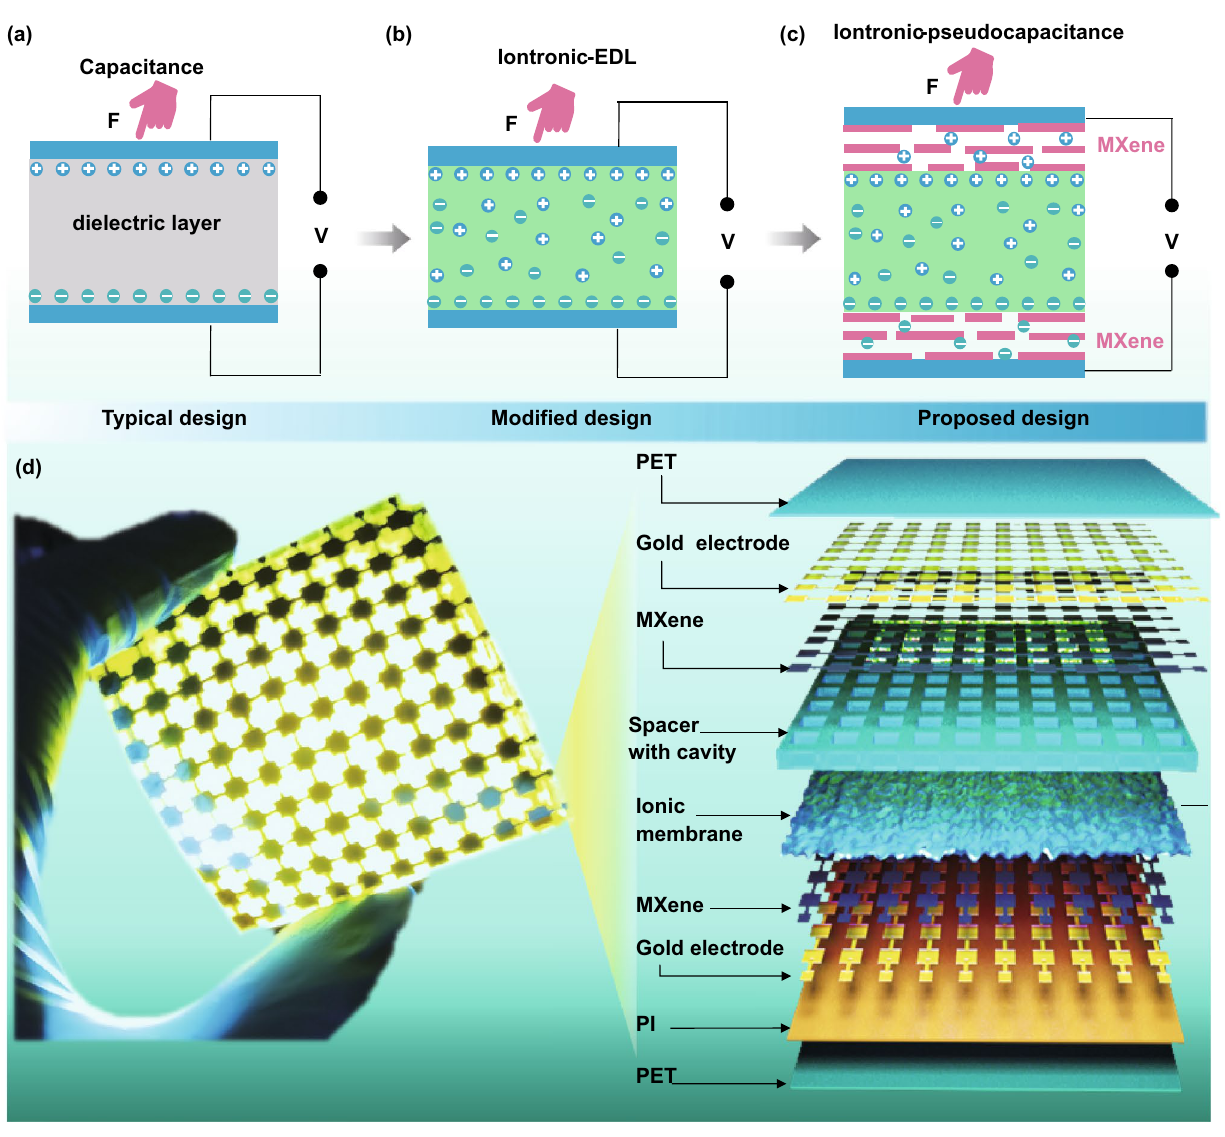
Fig. 1 Flexible TIPS layout and design. Schematic illustration of the mechanism of the a traditional PPS, b modified design and c proposed mechanism of our pseudocapacitance-derived sensors. d Digital optical image of the TIPS arrays under bending state and corresponding exploded view layout of the various layers in the